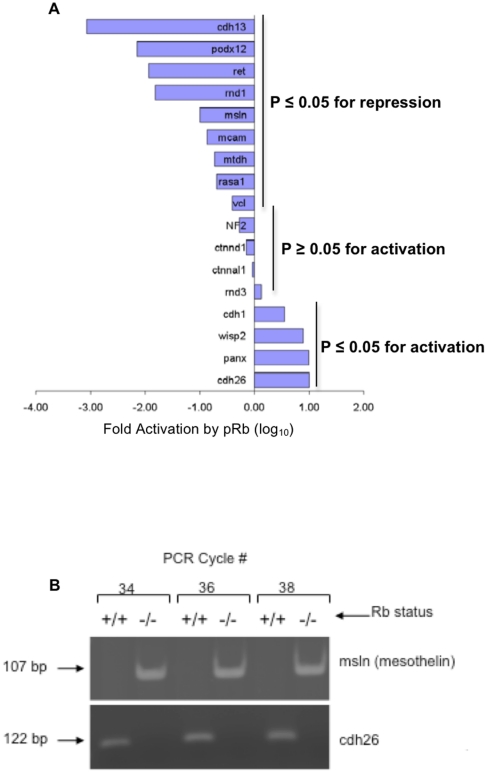
qRT-PCR verified genes identified as pRb-regulated by microarray analysis.(A) Eight up-regulated and 9 down-regulated genes were chosen for validation; x-axis represents the fold activation of gene expression in the presence of pRb (pRb+/+ osteoblasts divided by pRb−/− osteoblasts). Negative values mean the gene was repressed by pRb, while positive values indicate activation. Each bar corresponds to a different gene. All 9 genes repressed by pRb in microarray analyses were validated (P<0.05) while only 4 of the putative pRb-activated genes were validated (P<0.05). (B) We were unable to perform qRT-PCR on cdh26. Instead, this figure shows a semi-quantitative RT-PCR analysis of mesothelin and cdh26 levels. Results verify that cdh26 is up-regulated and mesothelin is down-regulated by pRb.